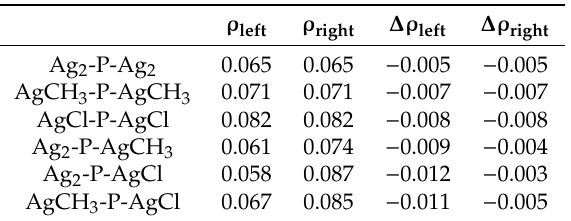
Table 6. Electron densities ( ρ , au) at the intermolecular BCPs in the ternary systems and their di ff erence ( ∆ ρ , au) relative to the binary ones.